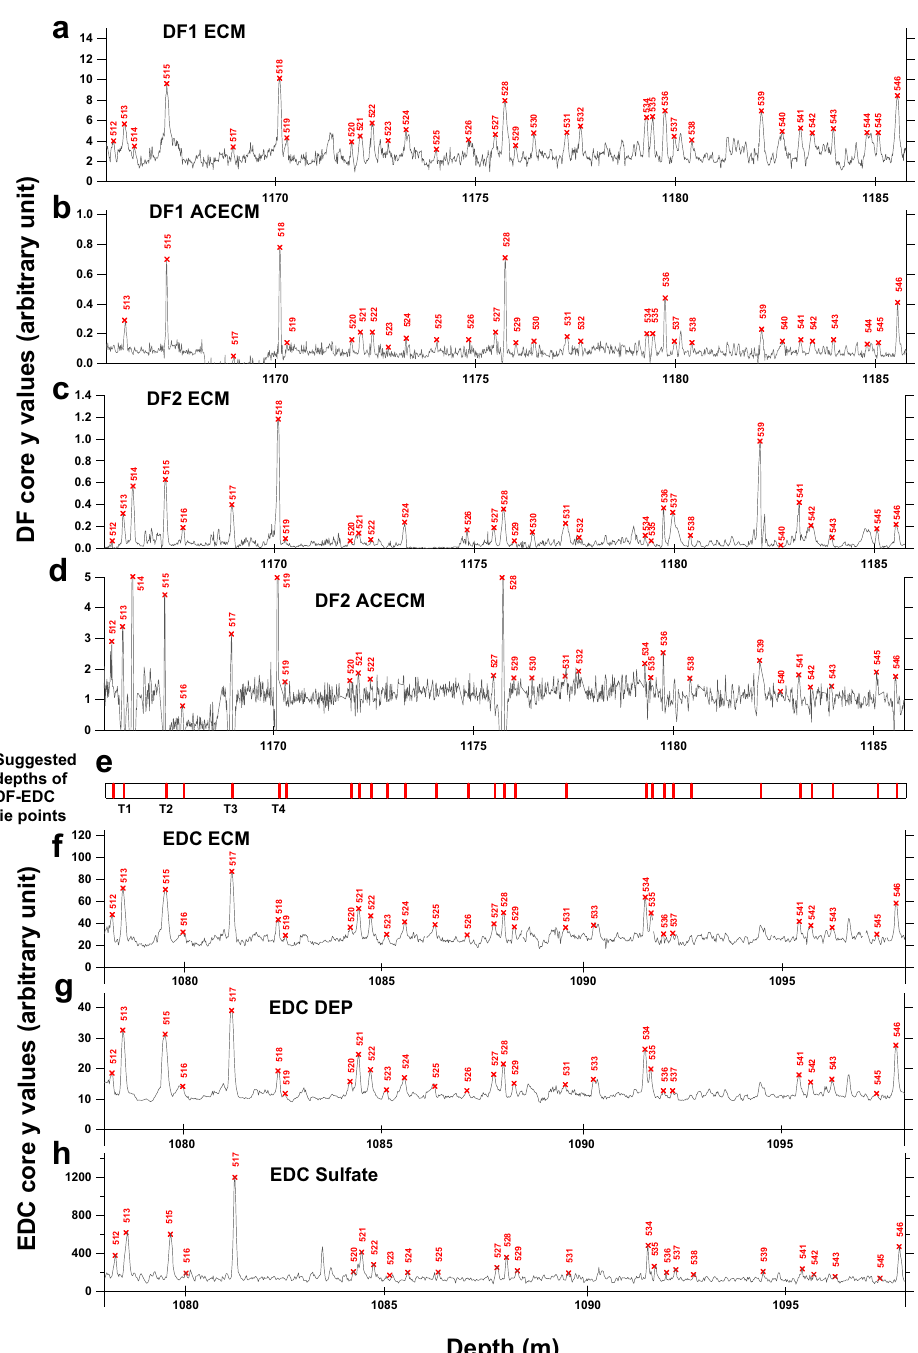
Figure 2. An example of a set of extracted tie points over a depth span of approximately 20m in both the DF and EDC cores. Graphs, from top to bottom, are for (a) DF1 ECM, (b) DF1 ACECM, (c) DF2 ECM, (d) DF2 ACECM, (e) suggested depths of tie points, (f) EDC DEP, (g) EDC ECM and (h) EDC sulfate (see Table 1). Scales of the y axes for the ECM, DEP and ACECM graphs are all arbitrary. Red markers with ID numbers (from 512 to 546) are spikes that were extracted using the PC interface (see Appendix A1). The presence of the same ID numbers in multiple graphs means that the spikes were identified as events from the same timings, that is, from the same origins of volcanic eruptions. The ID numbers are used only for the working purpose of synchronization. This set of examples contains a plausible Toba super-eruption that occurred sometime at ∼ 74kyr BP, studied by Svensson et al. (2013). Tie points with ID numbers 513, 515, 517 and 518 (shown as letters T1–T4 in e ) were discussed by Svensson et al. (2012; see their Fig. 8) as tie points of the Toba super-eruption. All data covering 216kyr are shown in the